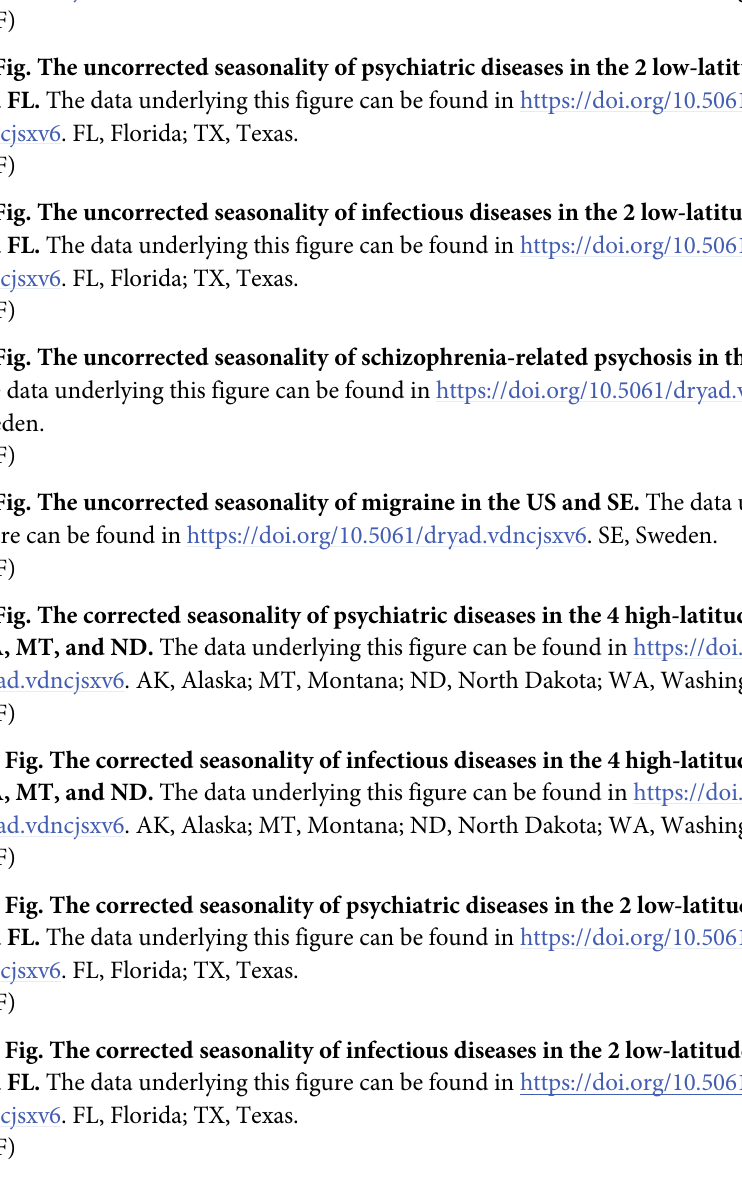
S2 Fig. The uncorrected seasonality of skin infection in the US. The data underlying this fig- ure can be found in https://doi.org/10.5061/dryad.vdncjsxv6. (TIF) S3 Fig. The uncorrected seasonality of psychiatric diseases in the 4 high-latitude states: AK, WA, MT, and ND. The data underlying this figure can be found in https://doi.org/10. 5061/dryad.vdncjsxv6. AK, Alaska; MT, Montana; ND, North Dakota; WA, Washington. (TIF) S4 Fig. The uncorrected seasonality of infectious diseases in the 4 high-latitude states: AK, WA, MT, and ND. The data underlying this figure can be found in https://doi.org/10.5061/ dryad.vdncjsxv6. AK, Alaska; MT, Montana; ND, North Dakota; WA, Washington. (TIF) S5 Fig. The uncorrected seasonality of psychiatric diseases in the 2 low-latitude states: TX and FL. The data underlying this figure can be found in https://doi.org/10.5061/dryad. vdncjsxv6. FL, Florida; TX, Texas. (TIF) S6 Fig. The uncorrected seasonality of infectious diseases in the 2 low-latitude states: TX and FL. The data underlying this figure can be found in https://doi.org/10.5061/dryad. vdncjsxv6. FL, Florida; TX, Texas. (TIF) S7 Fig. The uncorrected seasonality of schizophrenia-related psychosis in the US and SE. The data underlying this figure can be found in https://doi.org/10.5061/dryad.vdncjsxv6. SE, Sweden. (TIF) S8 Fig. The uncorrected seasonality of migraine in the US and SE. The data underlying this figure can be found in https://doi.org/10.5061/dryad.vdncjsxv6. SE, Sweden. (TIF) S9 Fig. The corrected seasonality of psychiatric diseases in the 4 high-latitude states: AK, WA, MT, and ND. The data underlying this figure can be found in https://doi.org/10.5061/ dryad.vdncjsxv6. AK, Alaska; MT, Montana; ND, North Dakota; WA, Washington. (TIF) S10 Fig. The corrected seasonality of infectious diseases in the 4 high-latitude states: AK, WA, MT, and ND. The data underlying this figure can be found in https://doi.org/10.5061/ dryad.vdncjsxv6. AK, Alaska; MT, Montana; ND, North Dakota; WA, Washington. (TIF) S11 Fig. The corrected seasonality of psychiatric diseases in the 2 low-latitude states: TX and FL. The data underlying this figure can be found in https://doi.org/10.5061/dryad. vdncjsxv6. FL, Florida; TX, Texas. S12 Fig. The corrected seasonality of infectious diseases in the 2 low-latitude states: TX and FL. The data underlying this figure can be found in https://doi.org/10.5061/dryad. vdncjsxv6. FL, Florida; TX,